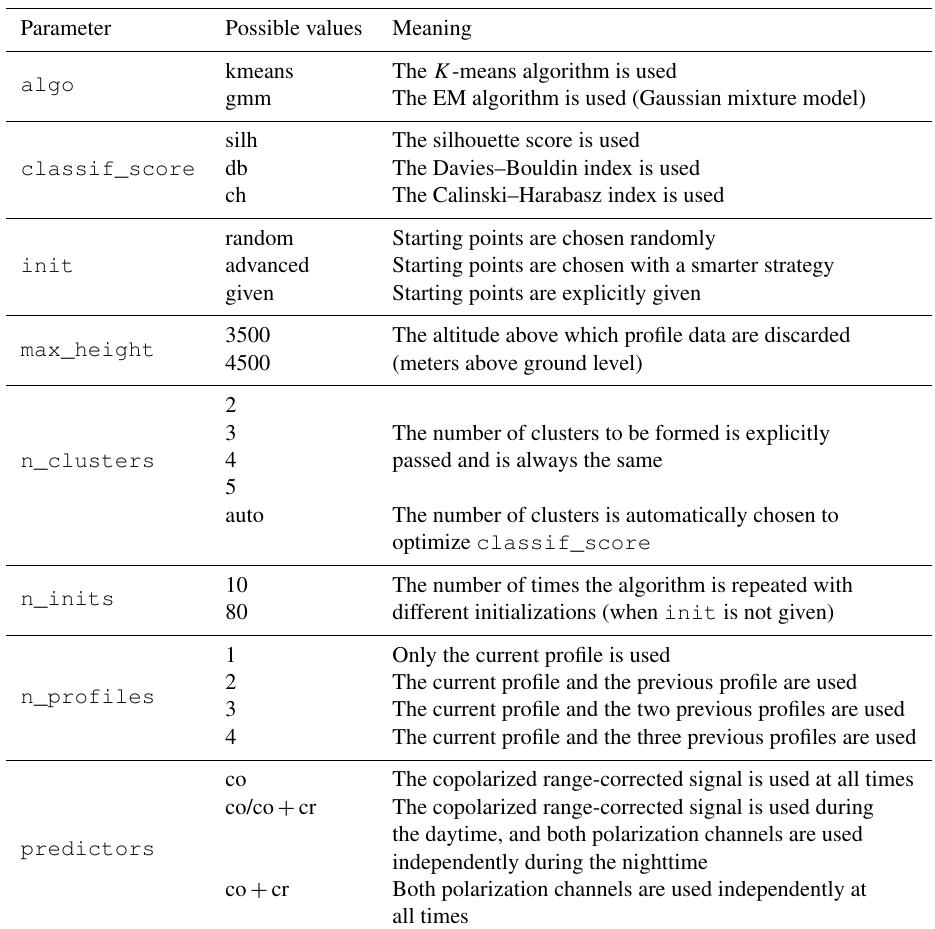
Table 2. Possible values for the parameters of the KABL code. The parameters are described in details in Sect. 3.3. The dependencies between parameters result in 3240 different